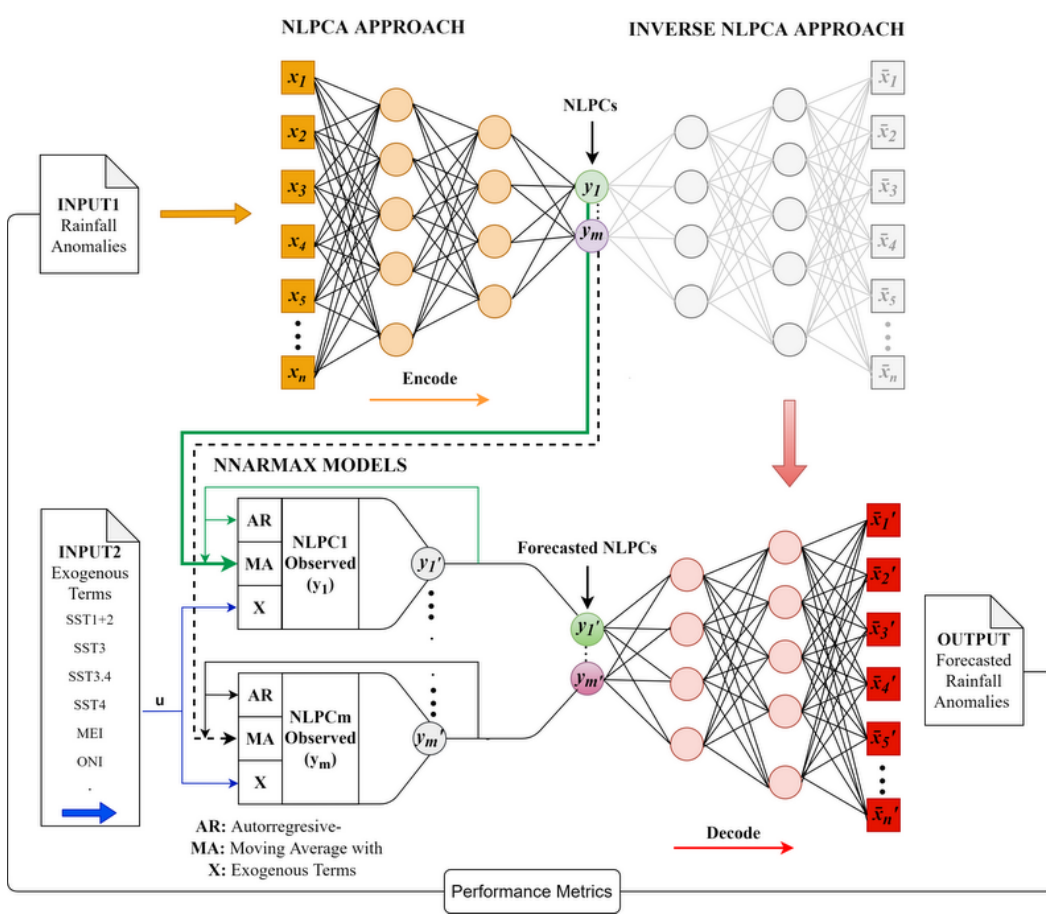
Figure 3. Flowchart of the methodology of the study. (cid:1876) (cid:3041) is the input layer (rainfall anomalies), (cid:1877) (cid:3040) is the bottleneck layer of the Non-linear Principal Component Analysis (NLPCA) model (observed Non-linear Principal Components (NLPCs)), (cid:1877) (cid:3040) ′ is the bottleneck layer of the inverse NLPCA model (forecasted NLPCs), and (cid:1850)(cid:3364) (cid:3041) ′ is the output layer (rainfall anomalies forecasted).